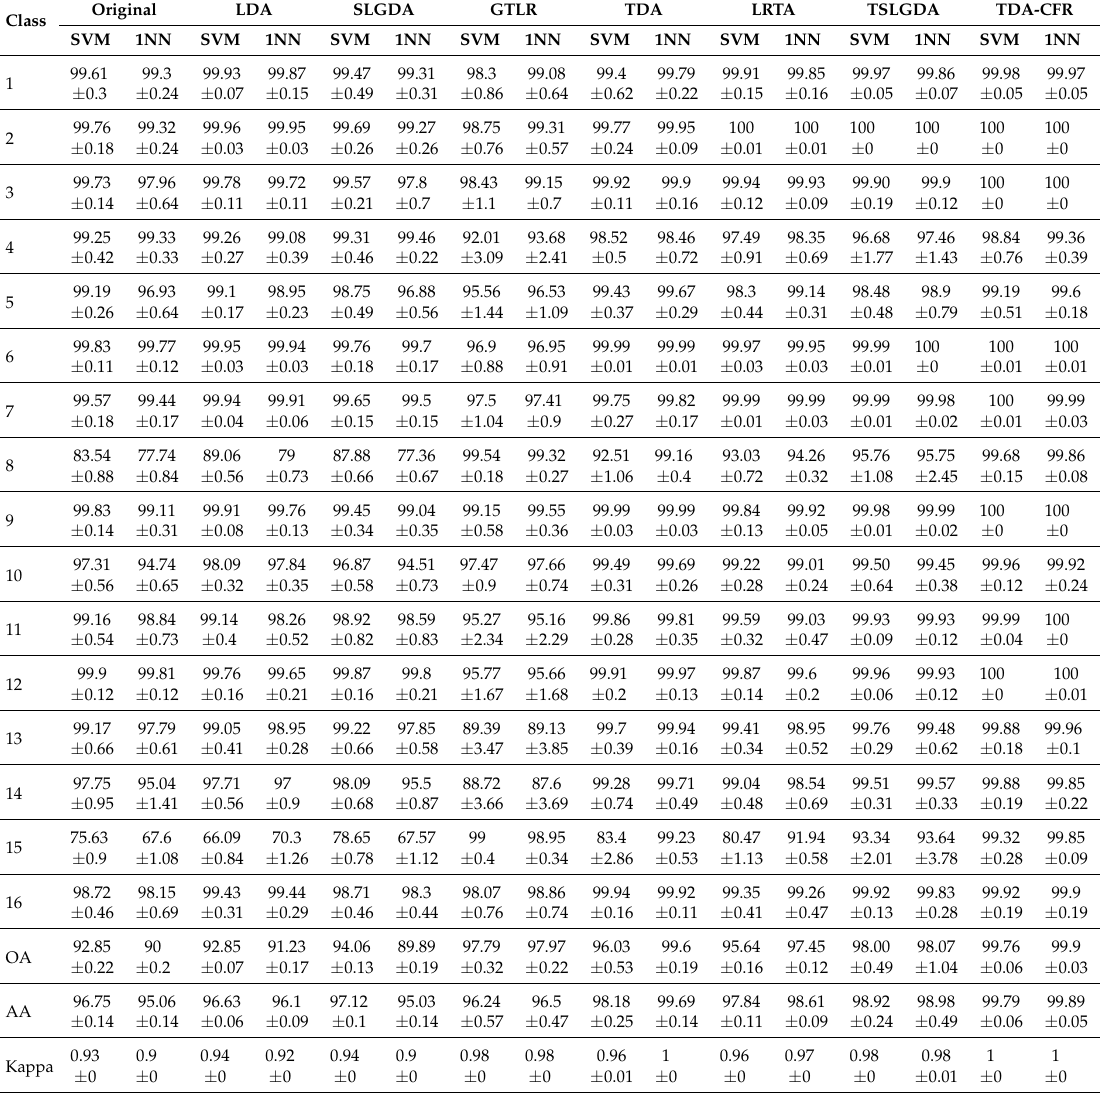
Table 3. Classification results on